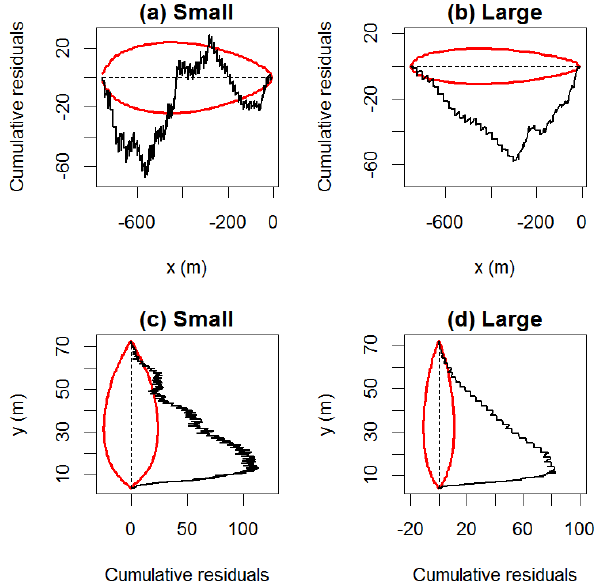
Figure 6. Lurking variable plots the summer 2006 displaying the point process residuals (cumulative raw) under the assumption of complete spatial randomness against the x coordinate (alongshore distance) and the y coordinate (cliff elevation relative to NGF69 datum) for small erosion scars ( a and c ), and for large erosion scars ( b and d ). The empirical plot (solid lines) is shown together with the pointwise two-standard-deviation limits (red lines).